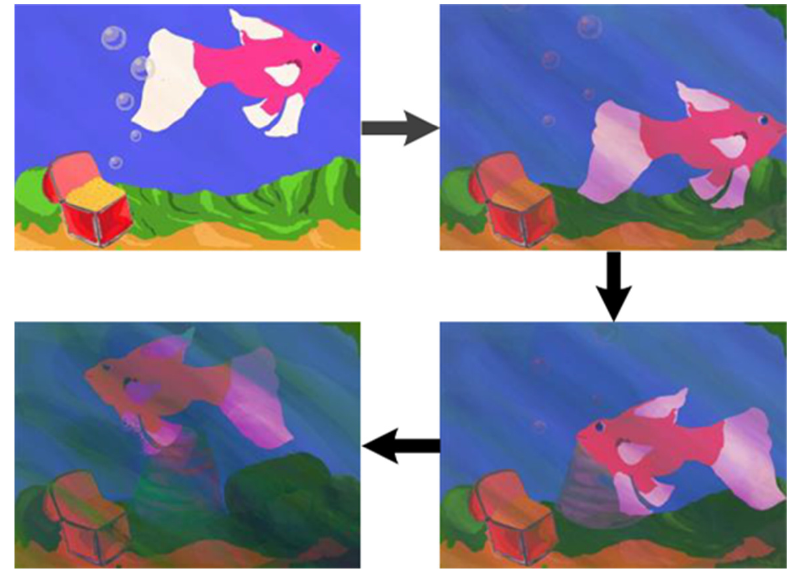
Figure 2. Application environment degradation.